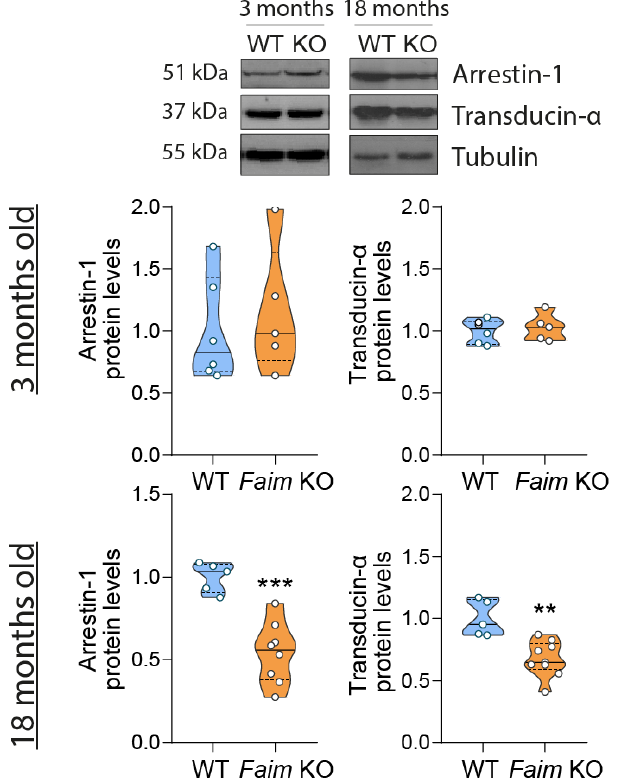
Figure 7. Protein levels of Arrestin-1 and Transducin- α are reduced at 18 months in Faim KO mice. Western blot analysis of Arrestin-1 and Transducin- α protein levels at 3 and 18 months of age in WT and Faim KO mice. Protein bands were quantified with ImageJ software levels and normalized to tubulin- α. Data are plotted relative to WT values an d represented in violin plots. Each violin plot extends from the min to max values, the median is represented by a thick dashed line, and quartiles are represented by thin dotted lines. N = 5 – 9 mice per group. Statistical analysis was performed using Stude nt’s t test. ** p < 0.01, *** p < 0.005.